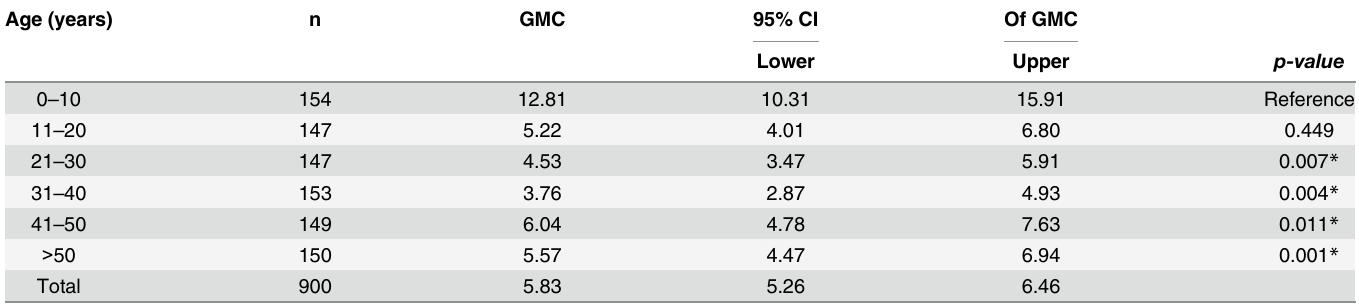
Table 1. Age-specific Geometric Mean Concentrations (GMC) of anti-pertussis toxin IgG in the Thai population.